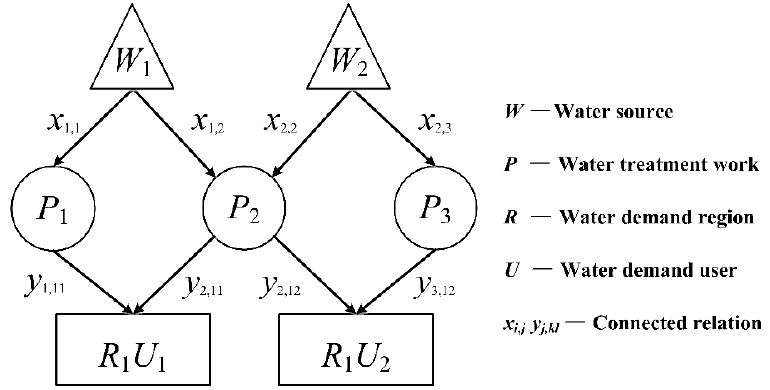
Figure A1. The sketch of Tianjin water supply system’s topology network. In Figure A1, W represents water source; P represents water treatment work; R represents water demand region; U represents water demand user. Topological relationship matrices are established to reveal topology information. The topological relationship matrix of the inter-basin water distributed to WTWs is represented by X , where x i,j represents the supply relationship between inter-basin water source i and WTW j . If WTW j is supplied by inter-basin water source i , then x i,j = 1, otherwise x i,j = 0. The topological relationship matrix of WTWs and users of each region is defined as Y , where y j,kl represents the supply relationship of WTW j and user l of region k . If user l of region k is supplied by WTW j , y j,kl = 1, otherwise y j,kl = 0. For example, the topological relationship matrices of Figure A1 are shown as